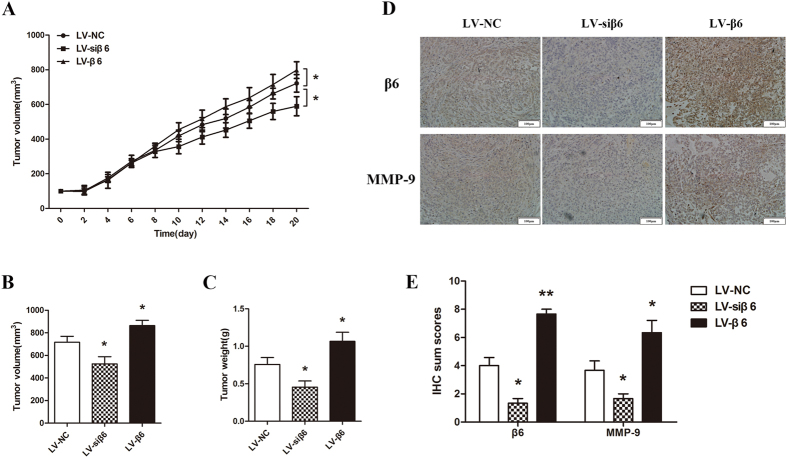
Integrin β6 effectively promoted tumor growth and MMP9 expression of subcutaneous xenograft tumors.The growth curves of tumors from the LV-NC, LV-siβ6 and LV-β6 groups. Tumors were isolated and measured. The mean volume of tumors in the LV-siβ6 group (n = 6) was significantly smaller than that of the control, while the LV-β6 group (n = 6) had a larger mean tumor volume. (A) The mean tumor weight was significantly lower in the LV-siβ6 group (n = 6) and higher in the LV-β6 group (n = 6) compared to the control. (B) The expression of integrin β6 and MMP9 was detected by IHC in paraffin-embedded tumor tissue sections. (C) IHC sum scores were used to determine the expression of integrin β6 and MMP9 in the xenograft tumor tissues. Data represent the mean ± SD. *P < 0.05; **P < 0.01.